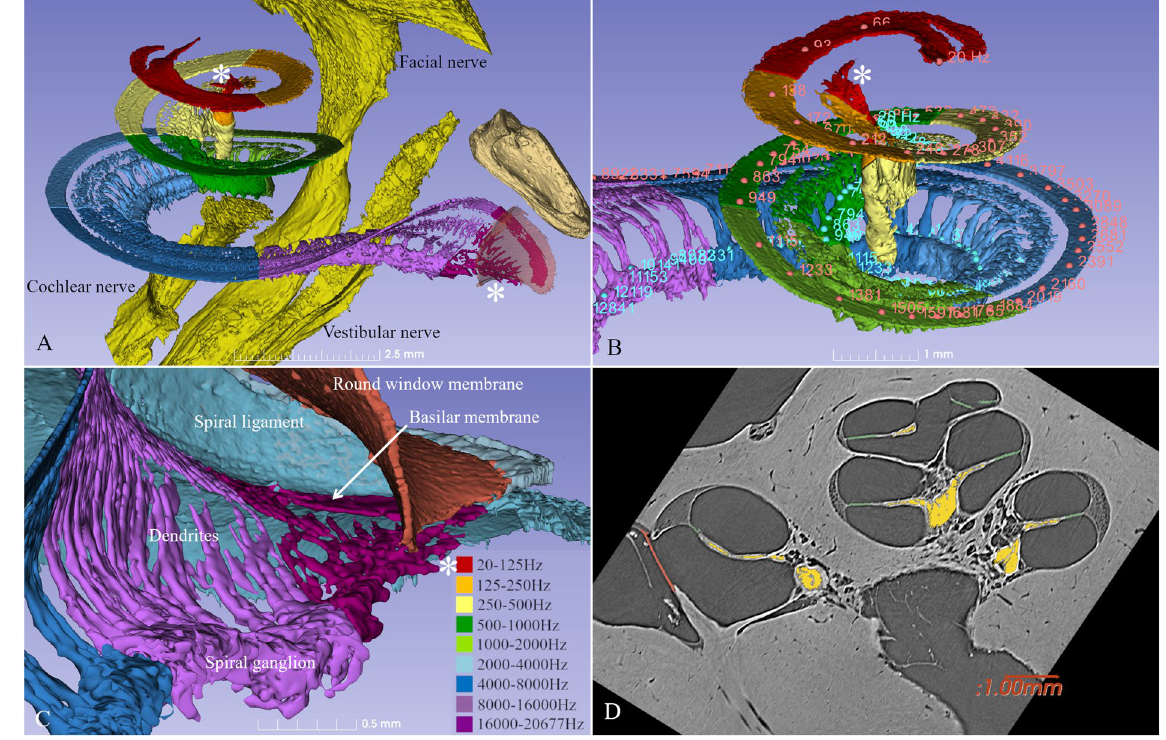
Figure 1. ( A ) SR-PCI data of a left human cochlea. 3D Slicer (www.slice r.org, version 4.10.1) 13 was used to create a detailed 3D representation including intra-cochlear soft tissue. The basilar membrane and spiral ganglion were segmented, and the frequency coordinates were calculated using Greenwood’s formula 14 and dendrite tracing. ( B , C ) For the spiral ganglion, the dendrites were traced from the basilar membrane to make a corresponding frequency map (shown with color scale). Note the angle of dendritic connections are not radial to the mid-modiolar axis in the apical and basal region (denoted by *). ( D ) Representative tomographic X-ray section showing the segmented round window (red), neural elements (yellow) and basilar membrane (green). GIMP 2 (www.gimp.org) was used to create the